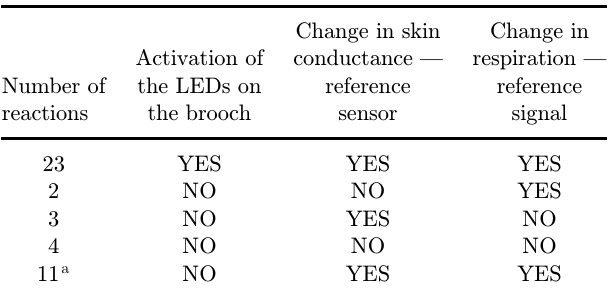
Table 1. Results of test measurement.